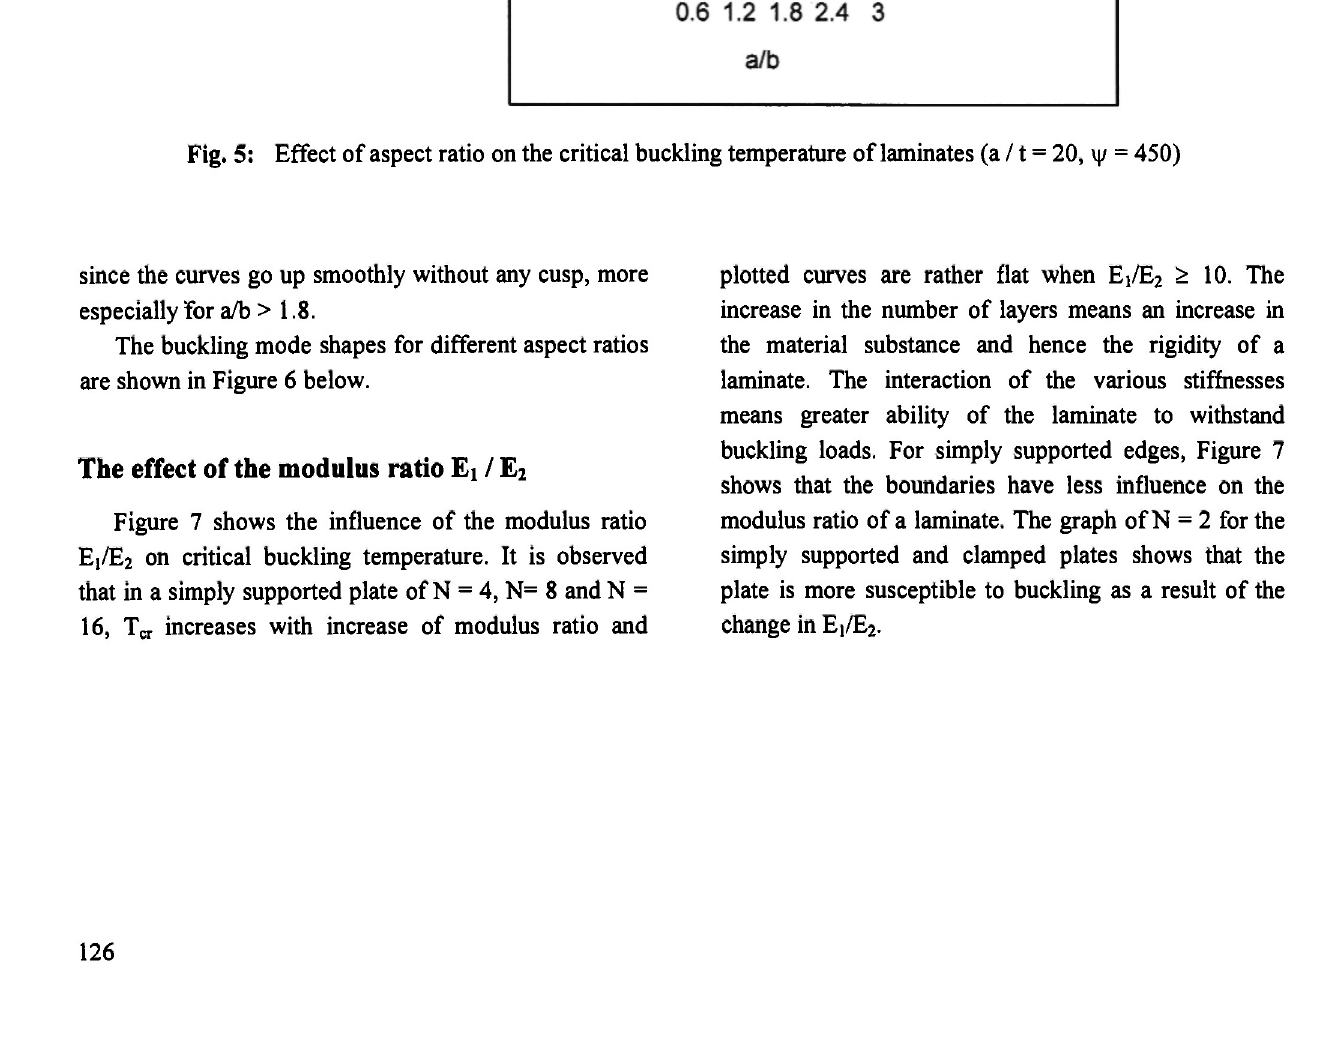
Fig. 5: Effect of aspect ratio on the critical buckling temperature of laminates (a /1 = 20, ψ = 450)